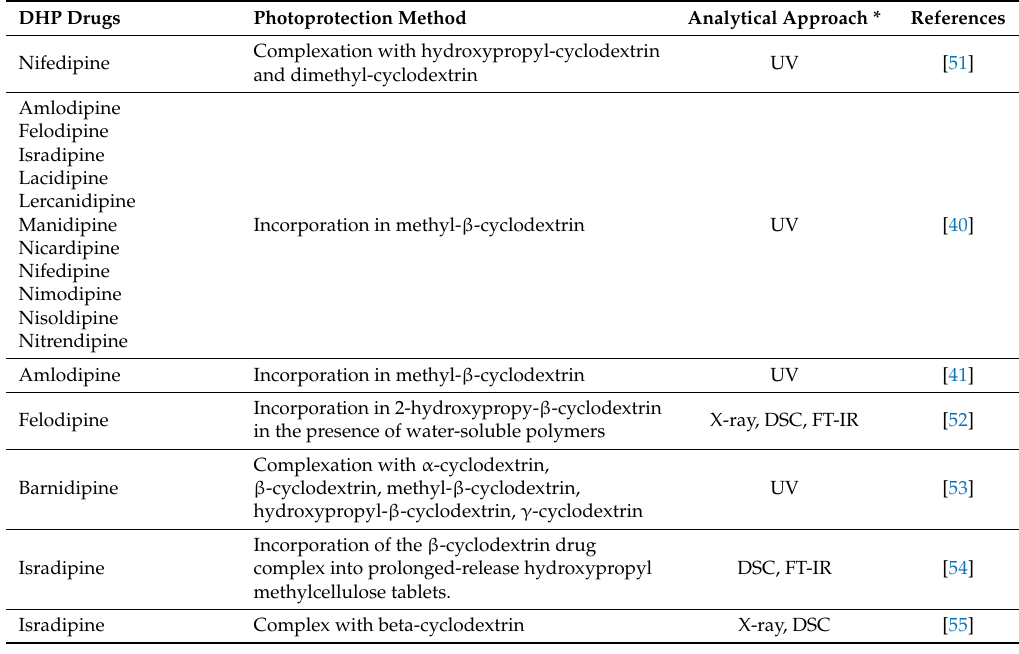
Table 4. Use of cyclodextrin